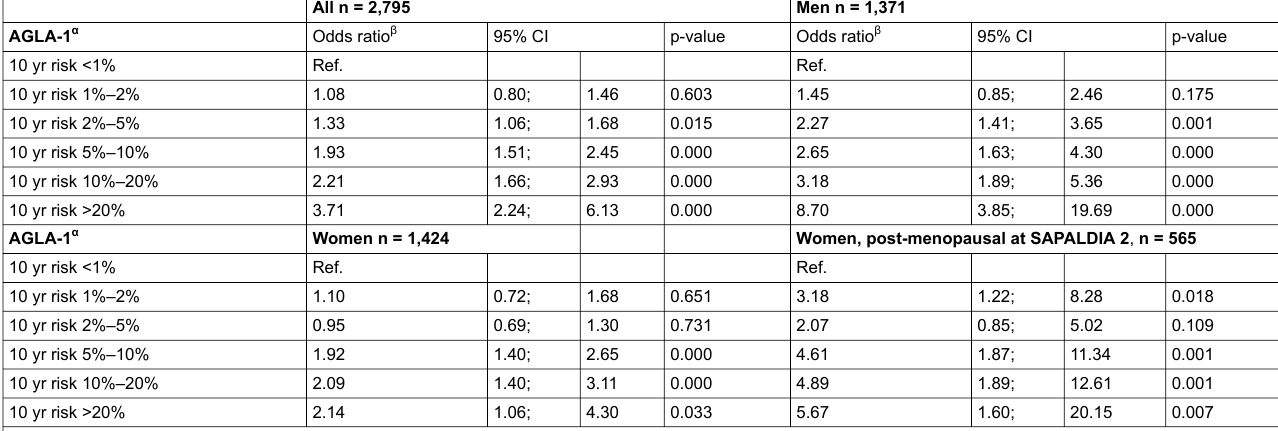
Table 3: Odds of developing a cardiovascular disease over the follow-up time from SAPALDIA 2 (2001/02) to SAPALDIA 3 (2010/11) by AGLA risk score in SAPALDIA 2, stratified by sex. All n = 2,795 Men n = 1,371 AGLA-1 α Odds ratio β 95%